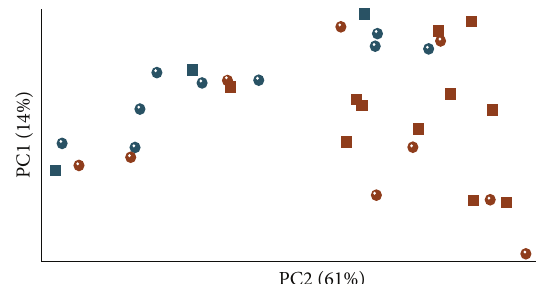
Figure 3: Beta Diversity analysis separates nonactive disease [light- blue] (12p40-mAb [circles] and healthy [squares]) from active colitis mice [orange] (rat-IgG2a [circles] and NaCl [squares]). PCoA plot (unscaled) was determined through weighted UniFrac metrics (ANOSIM, 𝑝 < 0.01 , 𝑟 = 0.18 ) of the colonic microbiota from 32 mice. The ellipsoids highlight the degree of variation around each